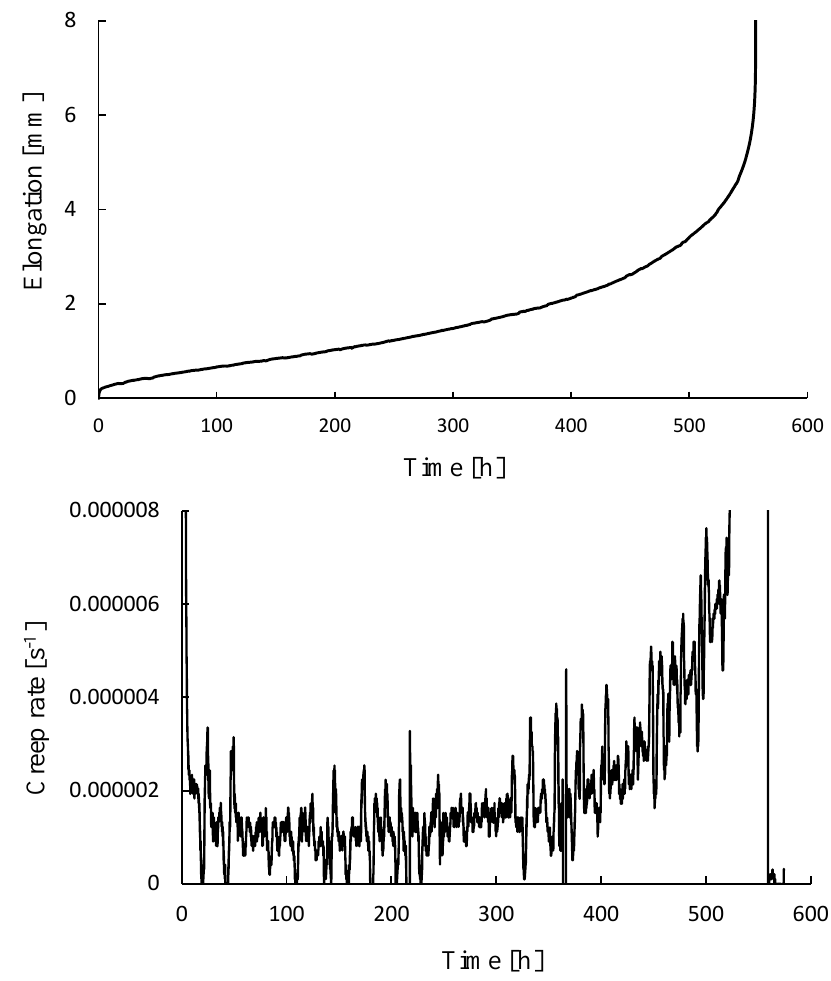
Figure 8. Creep rupture testing results for 10CrMo9–10 steel (T = 873 K, σ = 80 MPa).